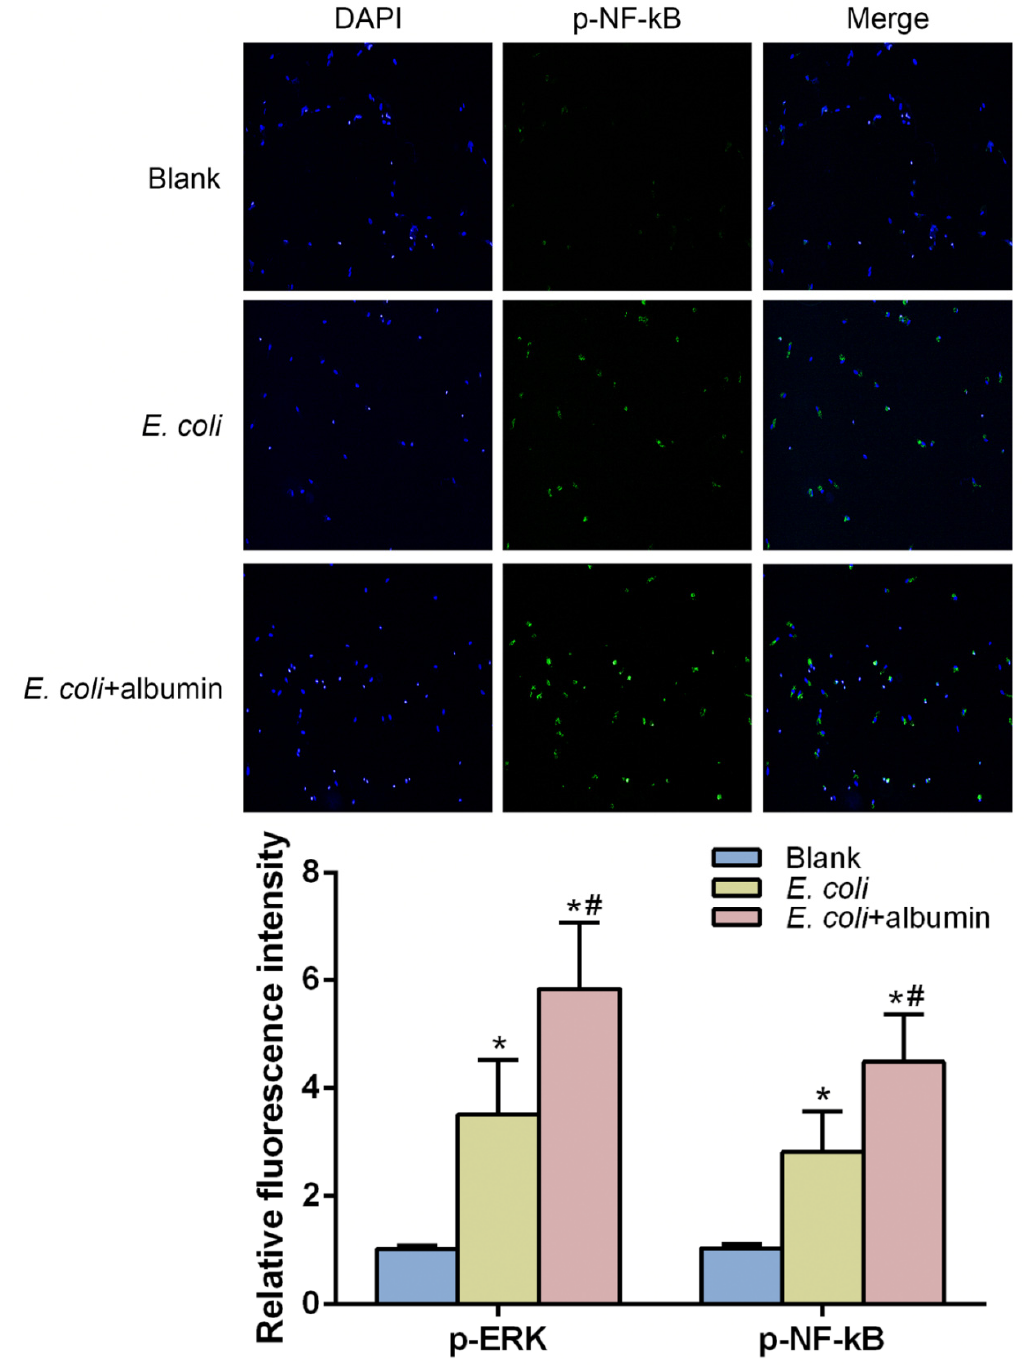
Figure 4. The potential mechanism of the protective effects of albumin in KCs. Immunofluorescence labeling of p-ERK and p-NF-kB protein (green) of KCs treated with albumin and E. coli . The nuclei were stained with 4 (cid:48) -6-diamidino-2- phenylindole (blue). Scale bars, 100 µ m. The relative fluorescence intensity compared with DAPI intensity in the staining experiments was measured. Data expressed as means ± SD, * p < 0.05 vs. blank group, # p < 0.05 vs. E. coli group, n = 6 in each group from three independent experiments with a total of three different human